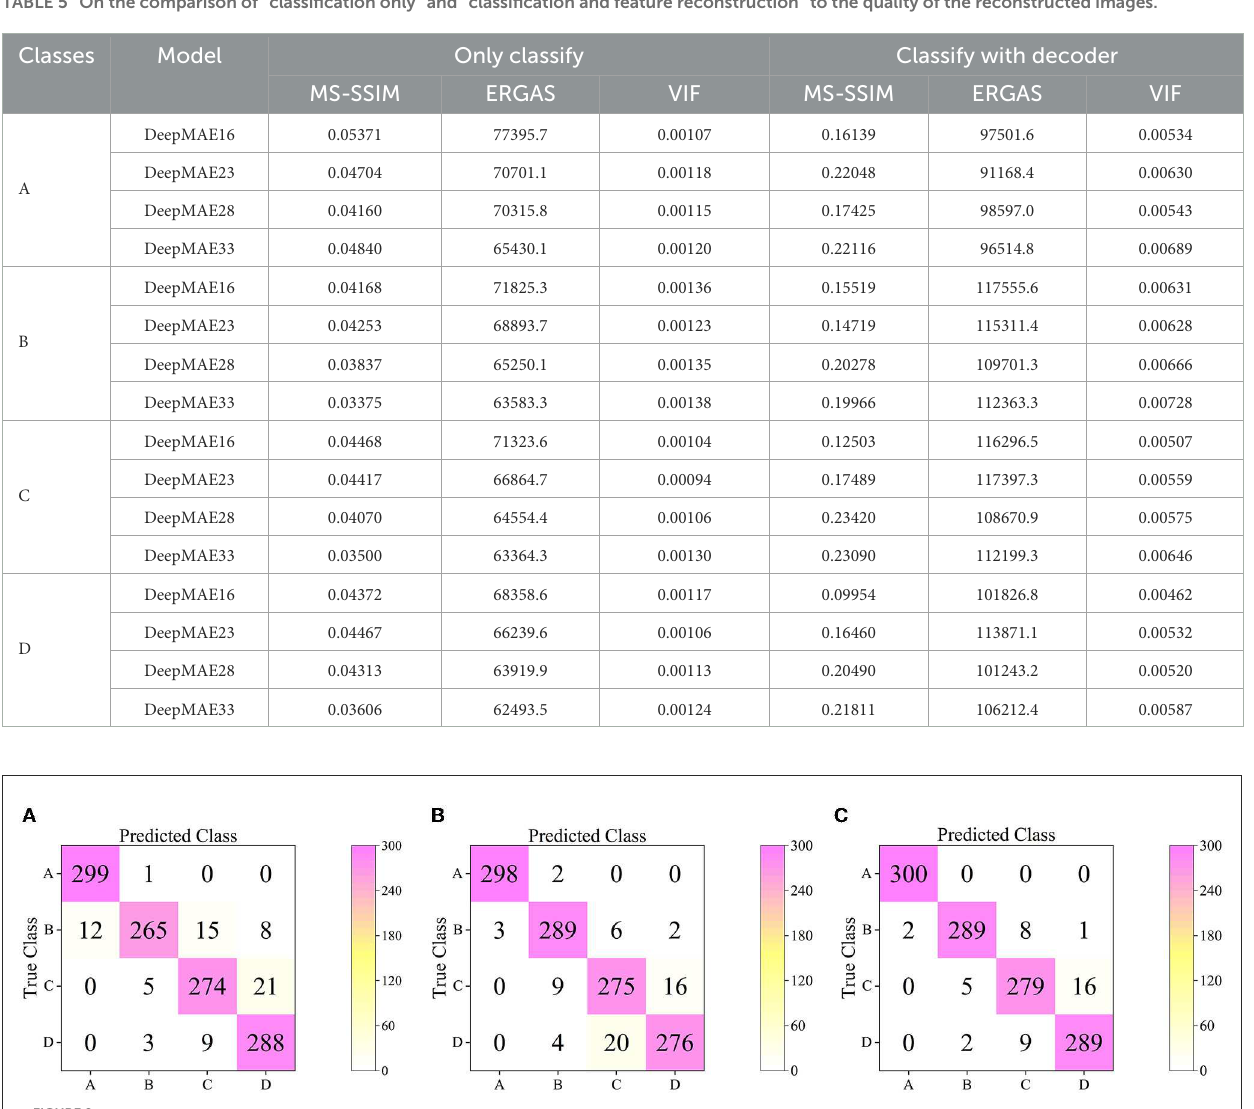
FIGURE9 Confusion matrices of MAE, VIT, and DEEPMAE on Test Dataset. The test set contains 300 images for each category. The number of predictions is shown in the column and the number of true labels is in the row. (A) The confusion matrix of MAE. (B) The confusion matrix of VIT. (C) The confusion matrix of DEEPMAE.